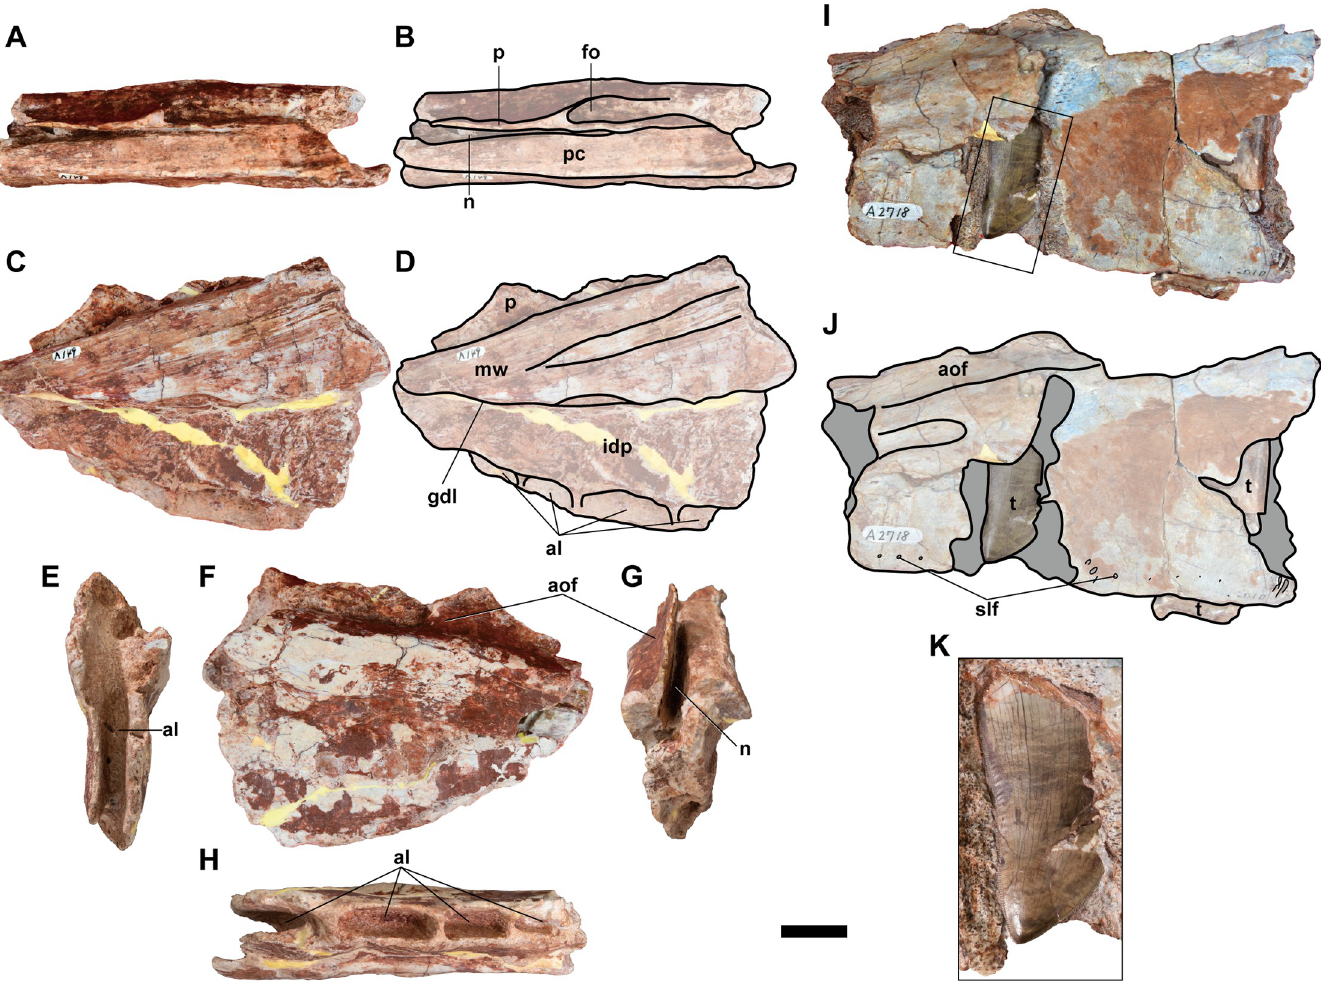
Fig 4. Left (A–H: NRRU-F01020005) and right (I, J; NRRU-F01020004) maxillae and an in situ maxillary tooth (K; NRRU-F010200040) in dorsal (A, B), medial (C, D), anterior (E), lateral (F, I–K), posterior (G) and alveolar (H) views. The rectangle in I indicates the area magnified in K to show a maxillary tooth. Abbreviations: al, alveolus; aof, antorbital fossa; fo, foramen; gdl, groove for dental lamina; idp, fused interdental plate; mw, medial wall; n, longitudinal notch; p, bony plate; pc, palatal contact; slf, superior labial foramina. Scale bar equals 20 mm for A–J and 10 mm for K.